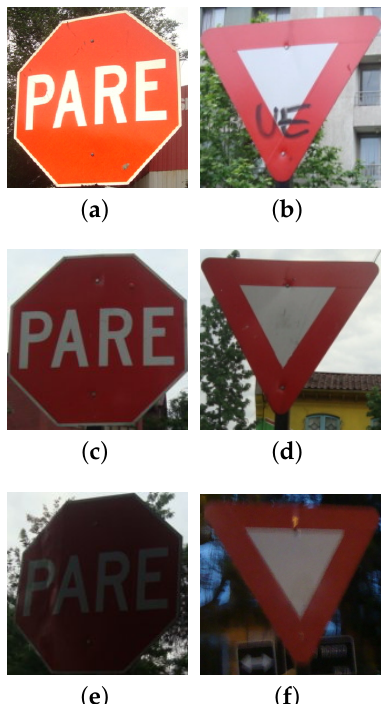
Figure 12. Typical traffic signs of road intersections and roundabouts in Chile: stop and yield signs; under different lighting conditions (sunny ( a , b ), normal ( c , d ) and dark ( e , f )) and observer positions.